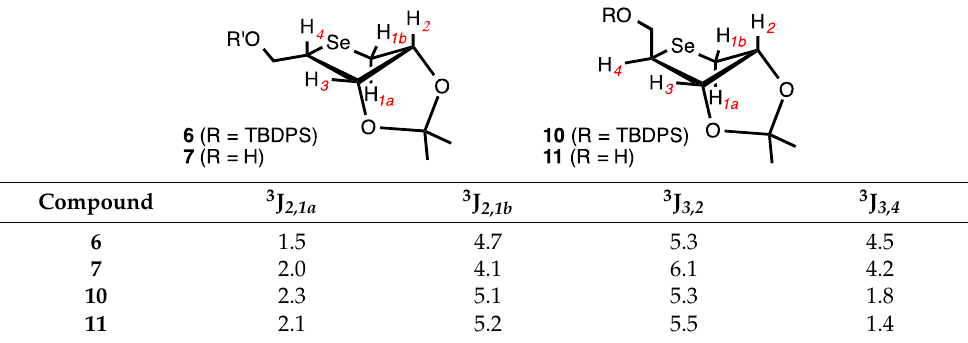
Table 1. Vicinal coupling constants. Comparative analysis.